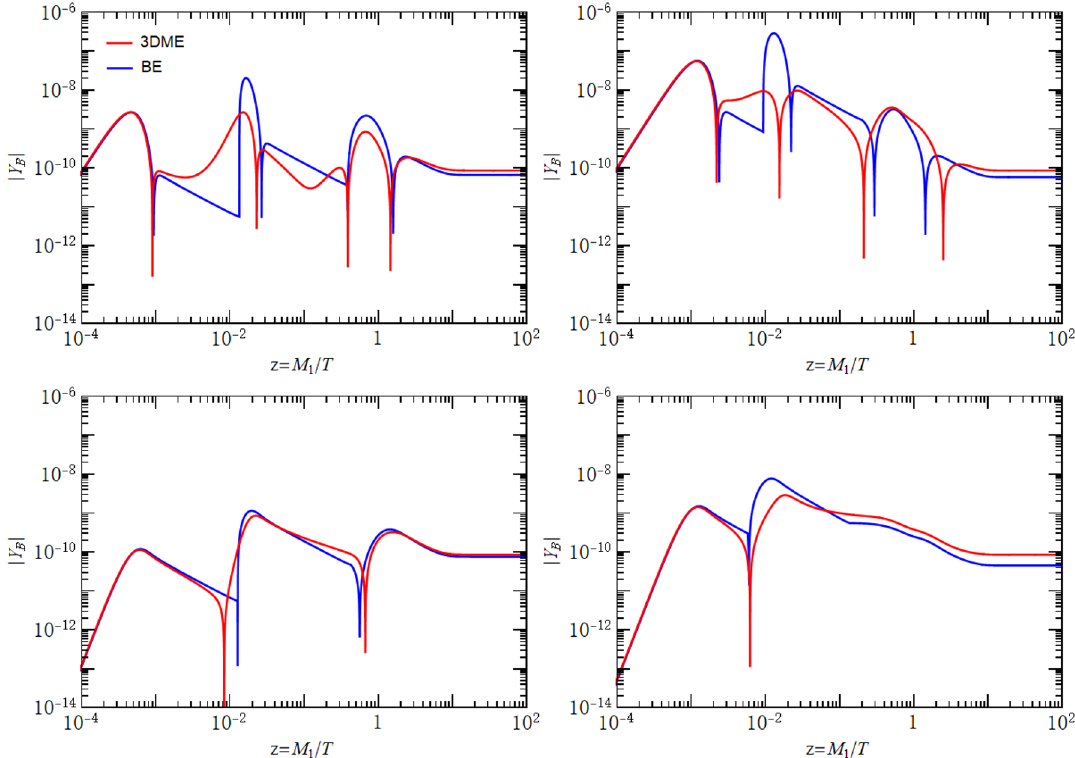
Figure 1 . The evolution of the baryon asymmetry Y B with temperature for the two benchmark models, the free parameters take the best fit values in table 3 and table 4. The red line and blue line are the numerical results obtained by solving the density matrix equation and Boltzmann equation of section 3.2 respectively. The top-left (right) panel is for the BM1 ( BM2 ) model with vanishing initial abundance. The bottom-left (right) panel for the BM1 ( BM2 ) model with thermal initial